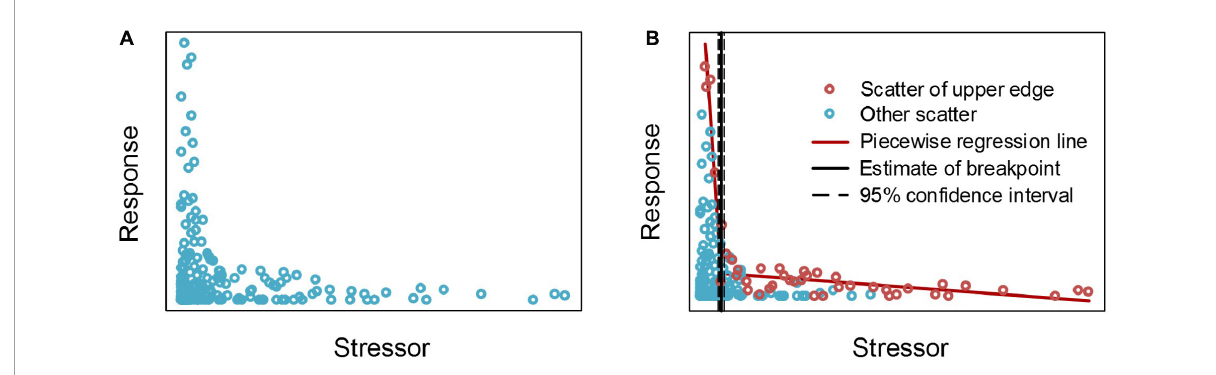
FIGURE2 Segmented analysis results of “L” shaped simulated scattered points after selecting the edge scatter. Panel (A) shows simulation of “L” shaped scattered points, panel (B) shows the selection of the edge scatter points and the segmented analysis results of edge scatter